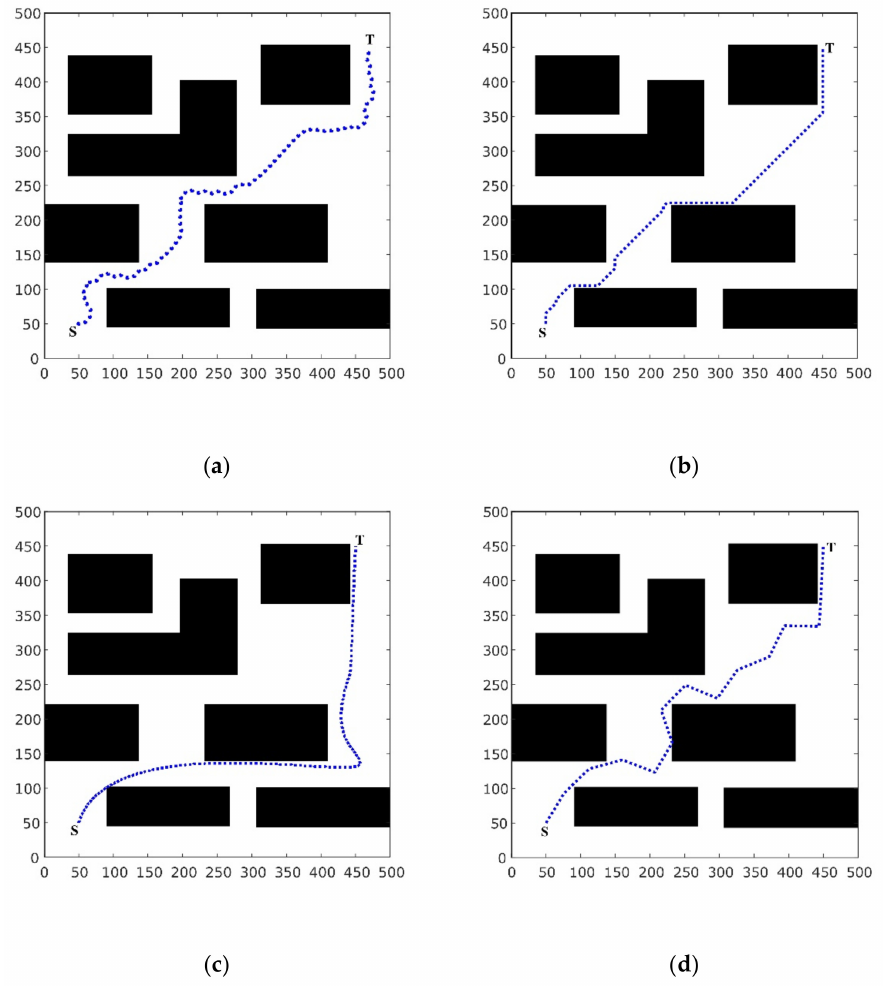
Figure 4. Environment II. The figures contain the simulation paths of the following algorithms: